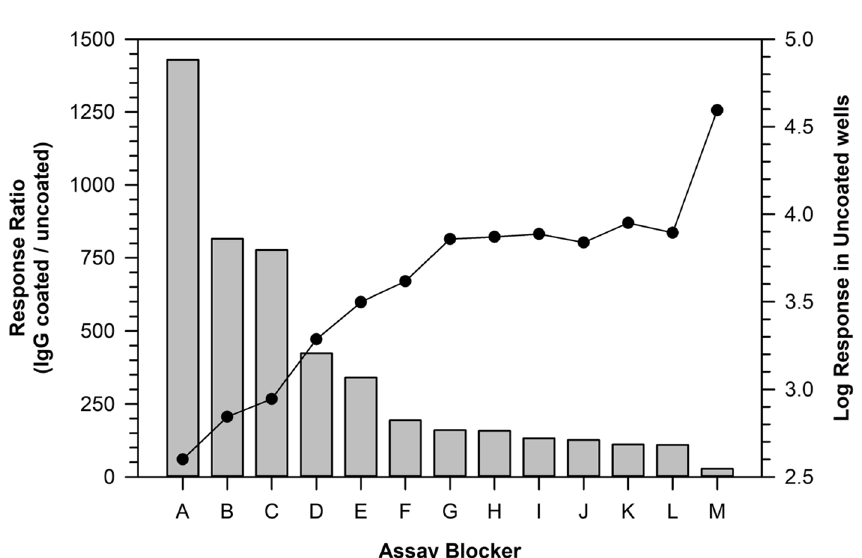
Figure 2. Effectiveness of different plate blocker and sample diluents for use in detection of serum immunoglobulins by SULFO-TAG labeled Protein-A/G. MSD plate wells were coated overnight with either 2 µg/mL human IgG or PBS (uncoated). On the following day, the wells were block using the different blocker- diluent buffers (A through M). A lot of pooled human serum was diluted 1/50 in the various blocker-diluents, added to the plate wells in duplicate and incubated at ambient temperature. After 1 h the plate was washed, and the IgG was detected by incubation with 0.2 µg/mL of SULFO-TAG labeled Protein-A/G diluted in PBS-2% BSA. The response ratio (bar graph) is RLU responses from the IgG coated wells relative to uncoated wells. Assay Blocker A is ChonBlock, B is Assay Diluent, C is Blocker casein in PBS, D is Low Cross buffer, and E is Monster Block. Blockers F through L, which produced similar response ratios, consisted of Starting Block, Super Block, Neptune Block, SynBlock and various combinations of BSA/HSA with PBS and TBS. The least effective blocker, M, was PBS alone. Closed circles depict the Log RLU from the uncoated wells and shows the wide range in non-specific binding responses seen among the different diluent